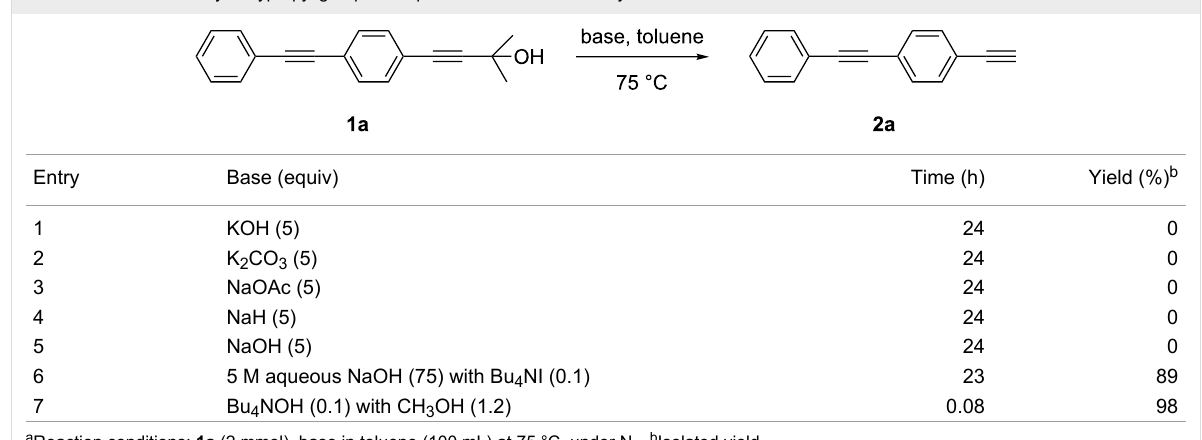
Table 1: Removal of 2-hydroxypropyl group in the presence of different catalysts a